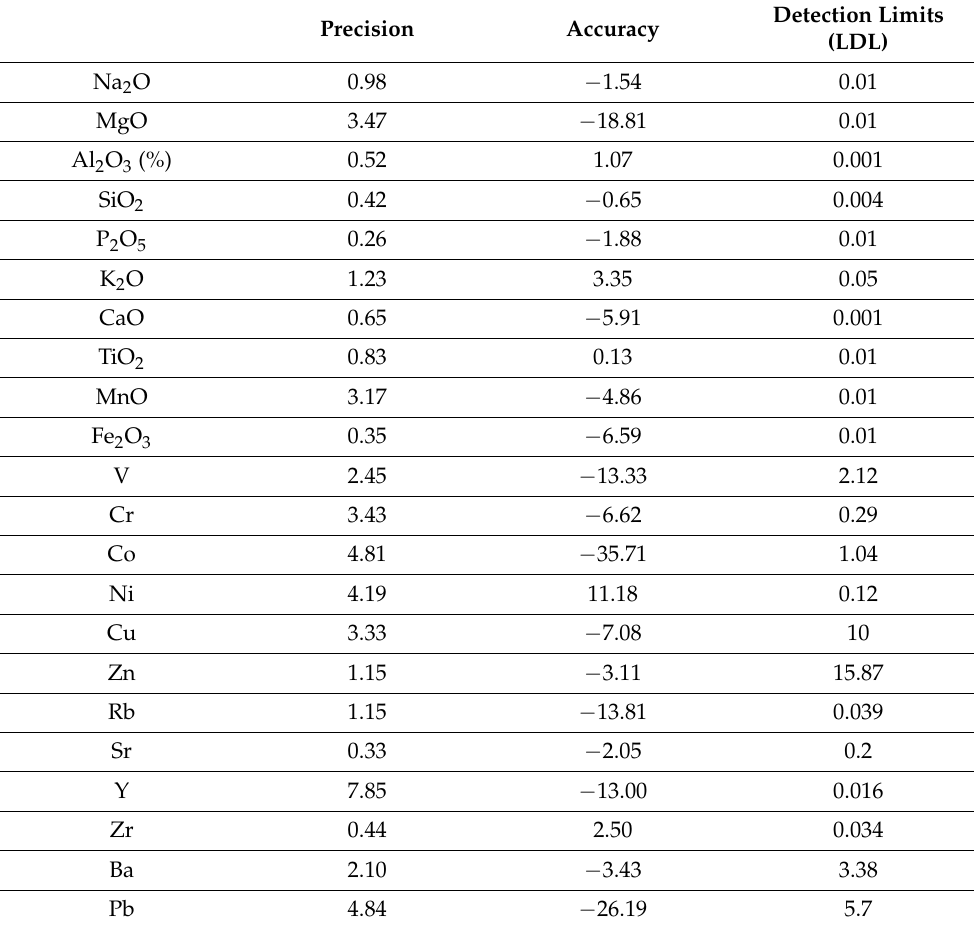
Table A1. Precision, accuracy, and detection limits of the WD-XRF of the Laboratory of Electron Microscopy and Microanalysis, University of Patras, Greece.